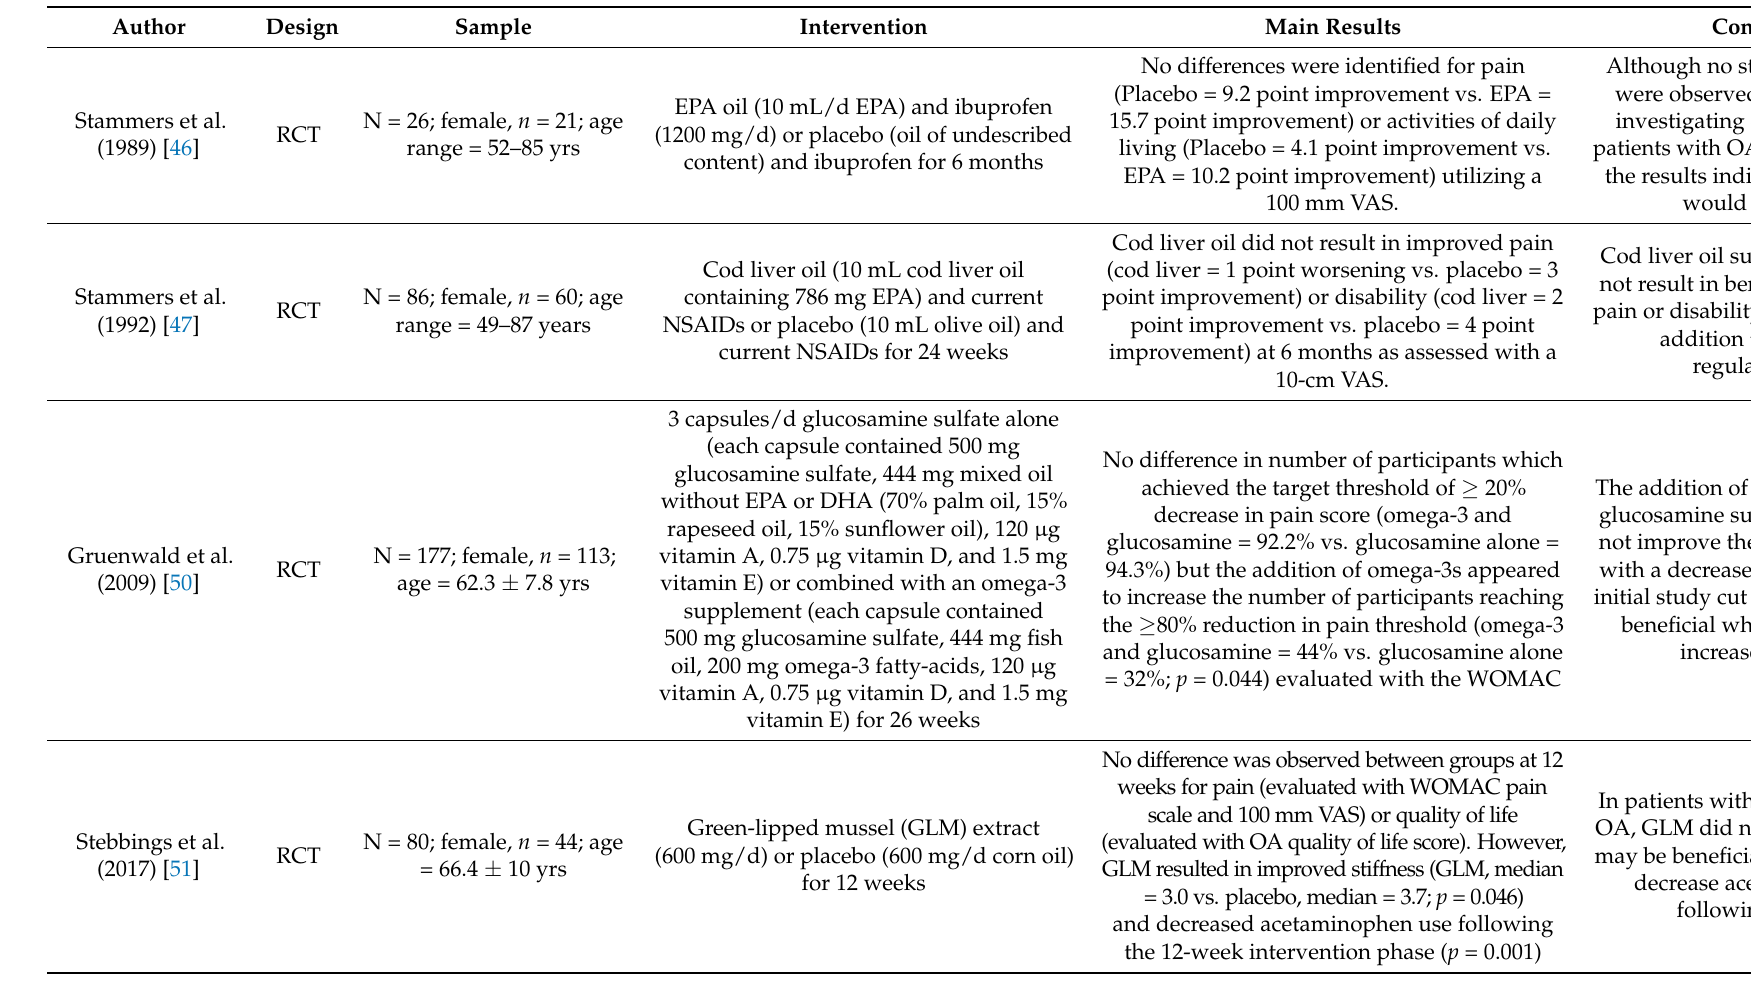
Table 1. Omega-3 in humans with